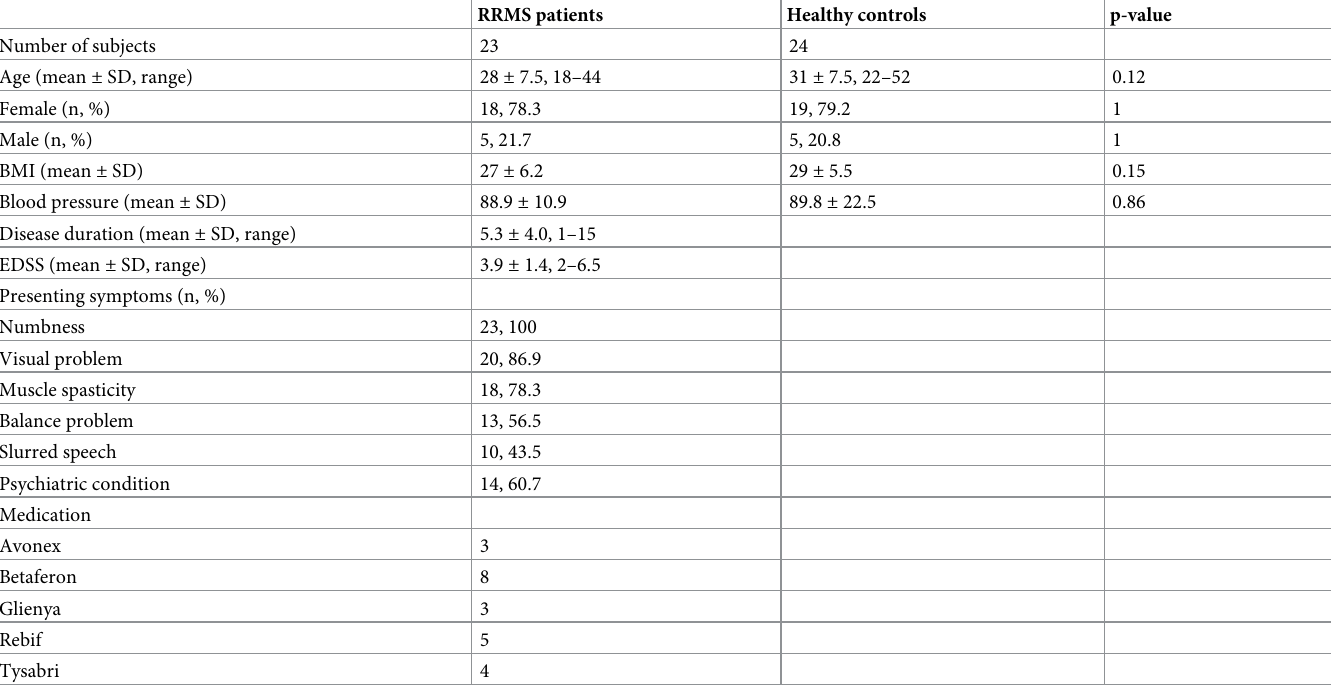
Table 1. Characteristics of study subjects.